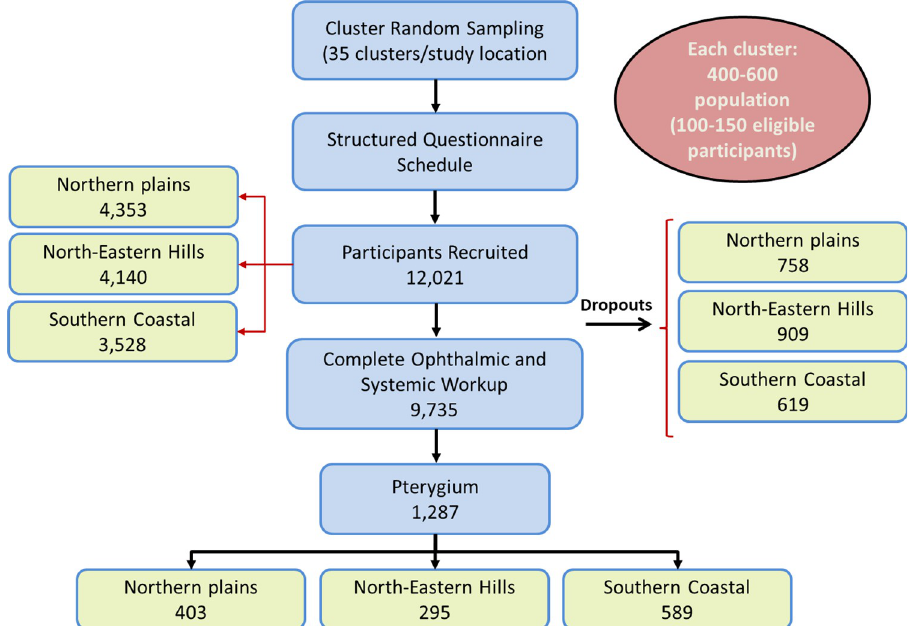
Fig 1. Flowchart depicting participant enrolment and study